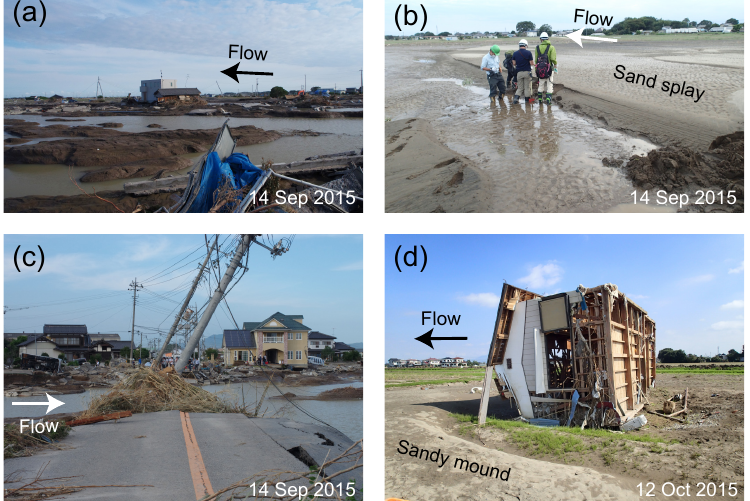
Figure 9. Photos of the study area. (a) Crevasse channel (breach scouring) near the levee. Note the building still standing after the flood in the center of the photo. (b) Sand splay in the southern part of the study area. (c) Damaged prefectural road beside the breached levee. (d) Overturned and transported house. Note the sandy mound in the downstream direction from the house. See Fig. 3c for the photo locations. Photos were taken by A. Izumida and T.